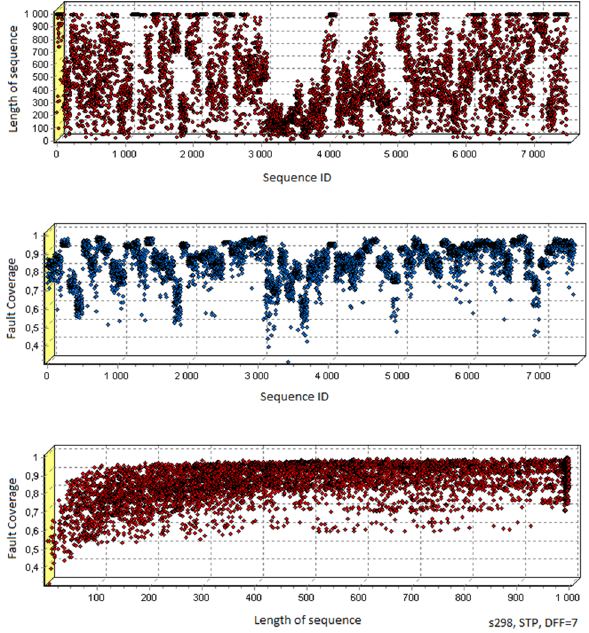
Fig. 28 STP for s298 with use of 7 internal